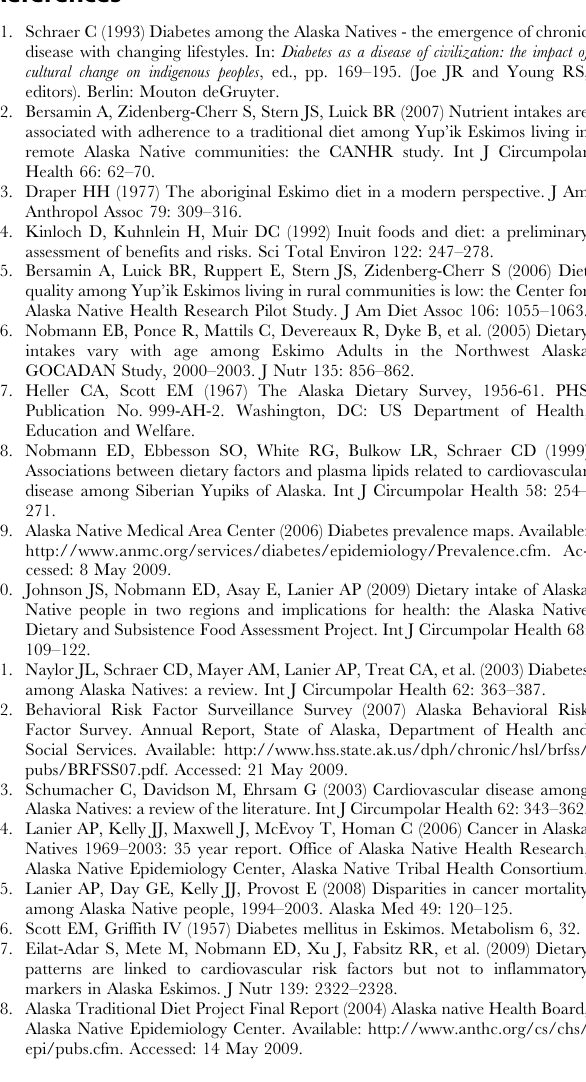
Table S1 Quantitative Food Frequency